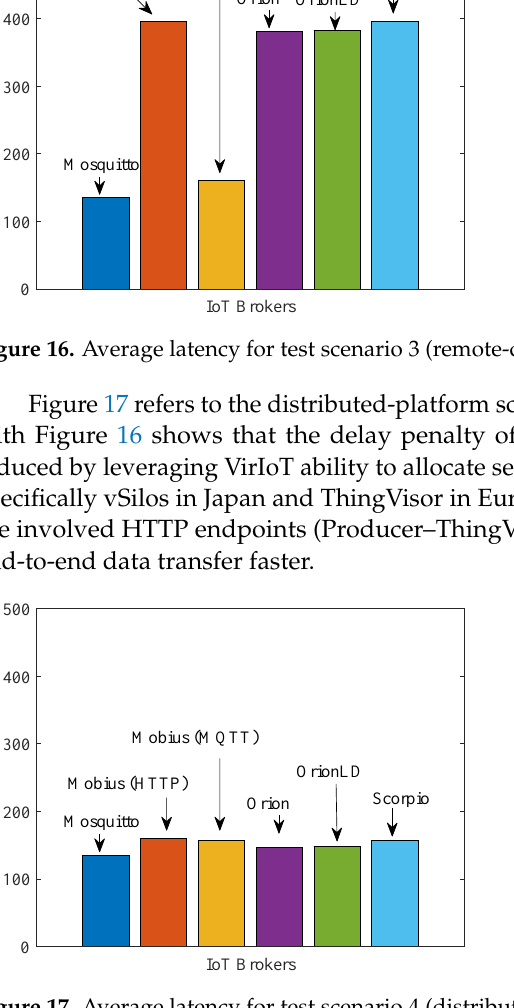
Figure 17. Average latency for test scenario 4